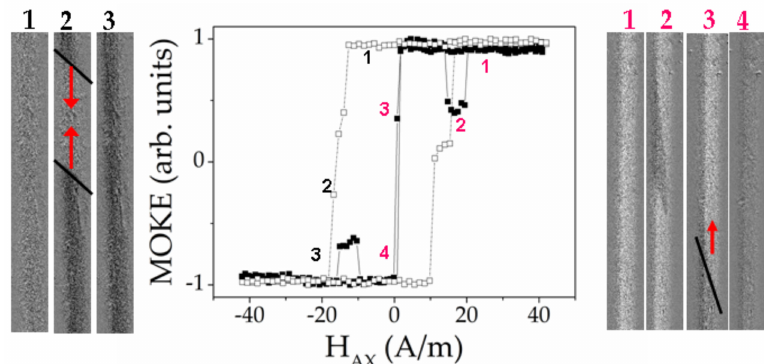
Figure 15. MOKE hysteresis loop (black points) and images of surface domain structure (marked by red numbers) obtained in sample № 3 annealed with tension stress. MOKE hysteresis loop (white points) and images of surface domain structure (marked by black numbers) obtained in sample 3 annealed with tension stress in the presence of the torsion of 2 π rad m − 1